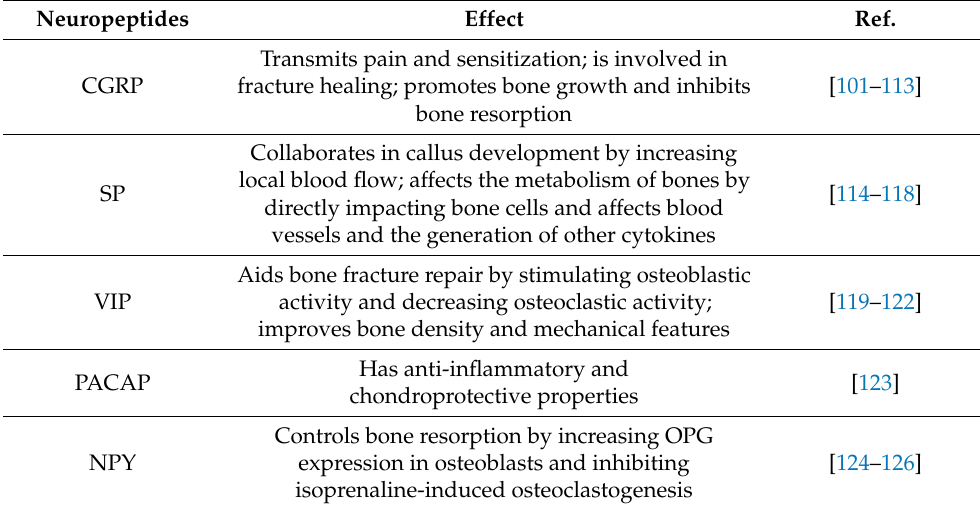
Table 2. The effect of neuropeptides on